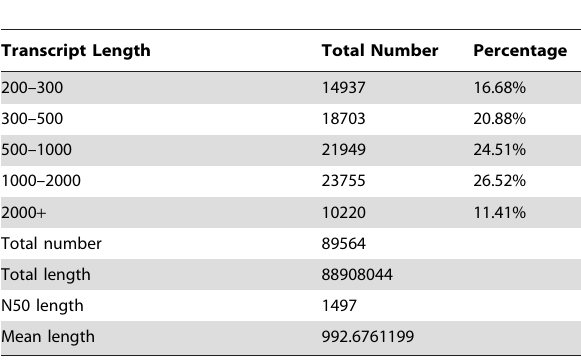
Table 1. Summary of sequencing and denovo assembling of plant transcriptome in Youngiajaponica